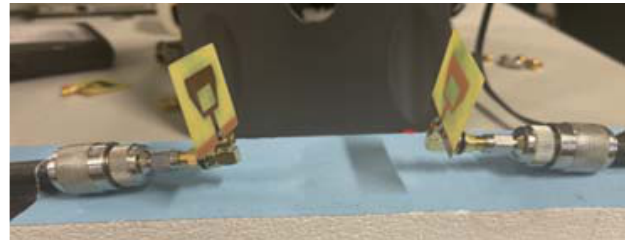
terms of scattering parameters or S parameters, were used and analyzed to determine the variation in blood pressure. To analyze the possible performance of antennas on a human arm, the transmitting antenna is attached to one side of the upper human arm and the receiving antenna is attached to the opposite side as shown in Figure 11. Figure 10. Two fabricated antennas in free space separated by 6.5 cm.